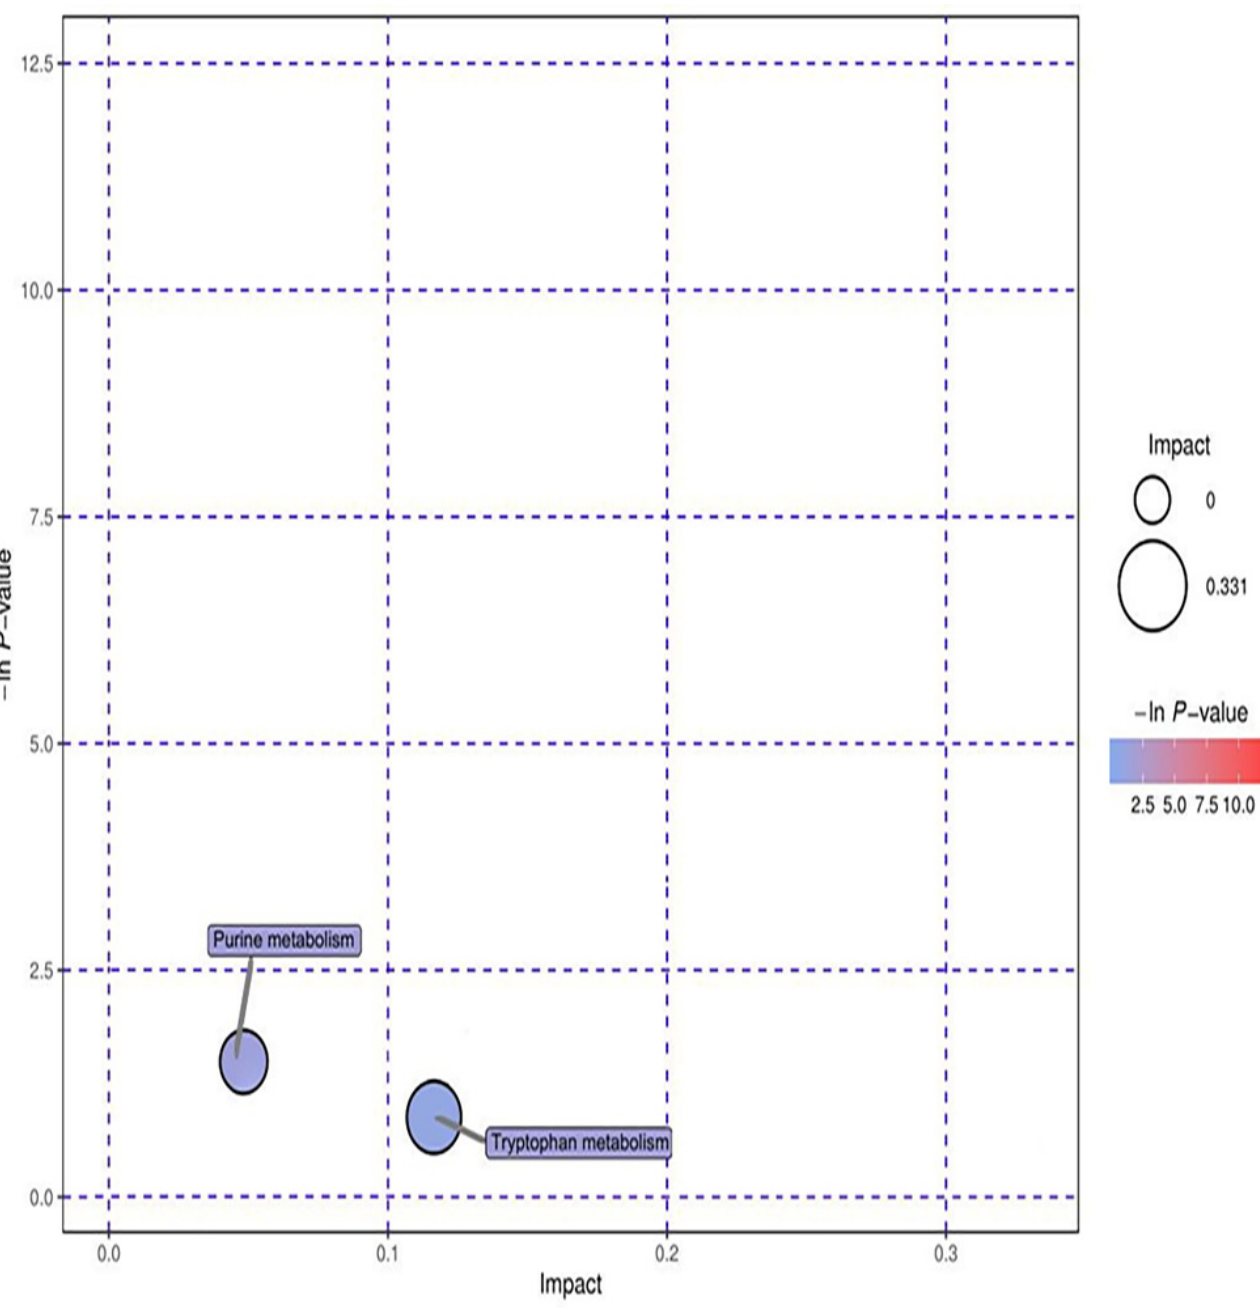
Figure 14. Topological analysis diagram of anion. The ordinate of metabolic topological analysis was -ln(P), and the value of P represents significance. The lower the value of P and the higher the value of -lnP, the more significant the enrichment of metabolites in this pathway. The abscissa impact was the path influence value. The greater the influence value of the pathway, the more likely the metabolites of the query were consistent with the metabolites of the